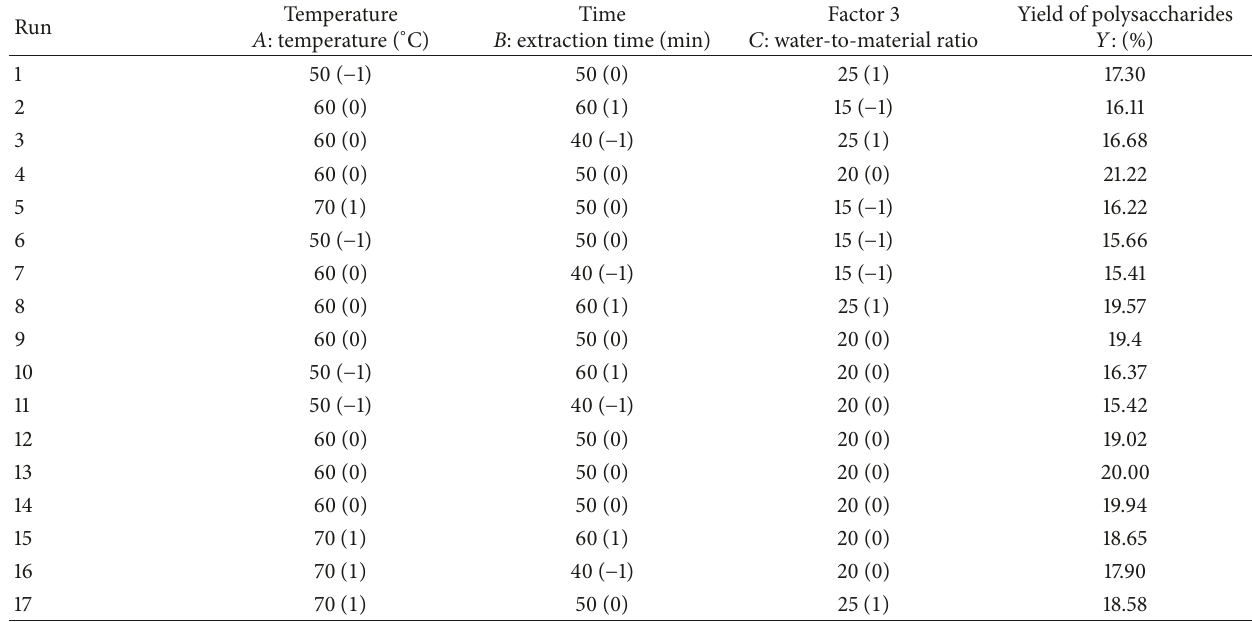
Table 1: Response surface analysis program and results for the yield polysaccharides from D. devonianum flowers.